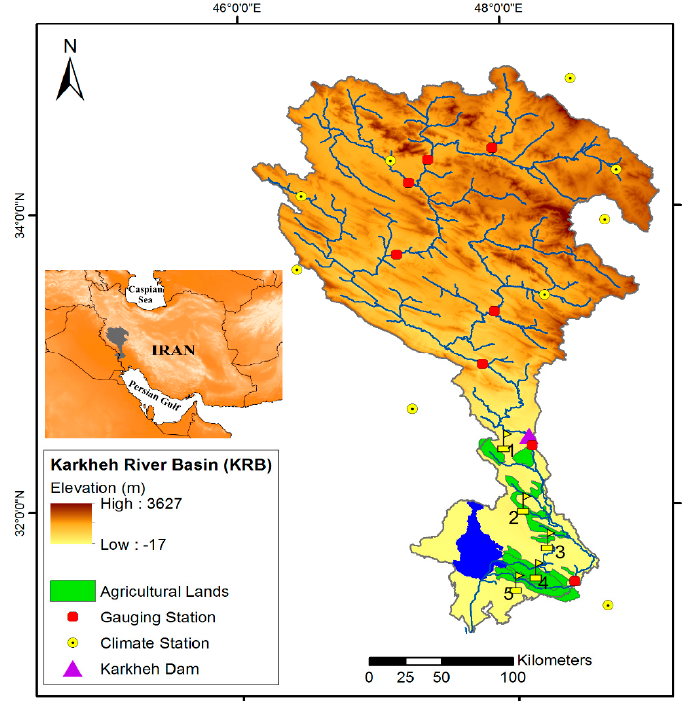
Figure 1. The five important agricultural regions in lower Karkheh River Basin: 1—Dashte Abbas, 2— Dolsagh, 3—Arayez, 4—Hamidiyeh, 5—Azadegan.